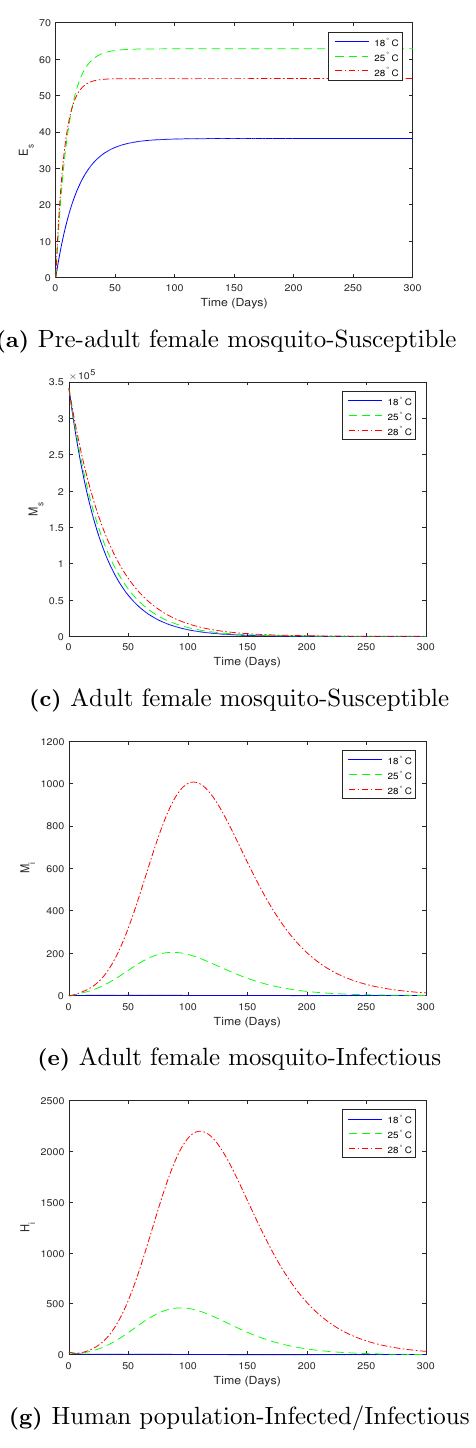
Figure 2. Simulation results of the fractional order dengue model at temperature 18 ◦ C, 25 ◦ C and 28 ◦ C with α =